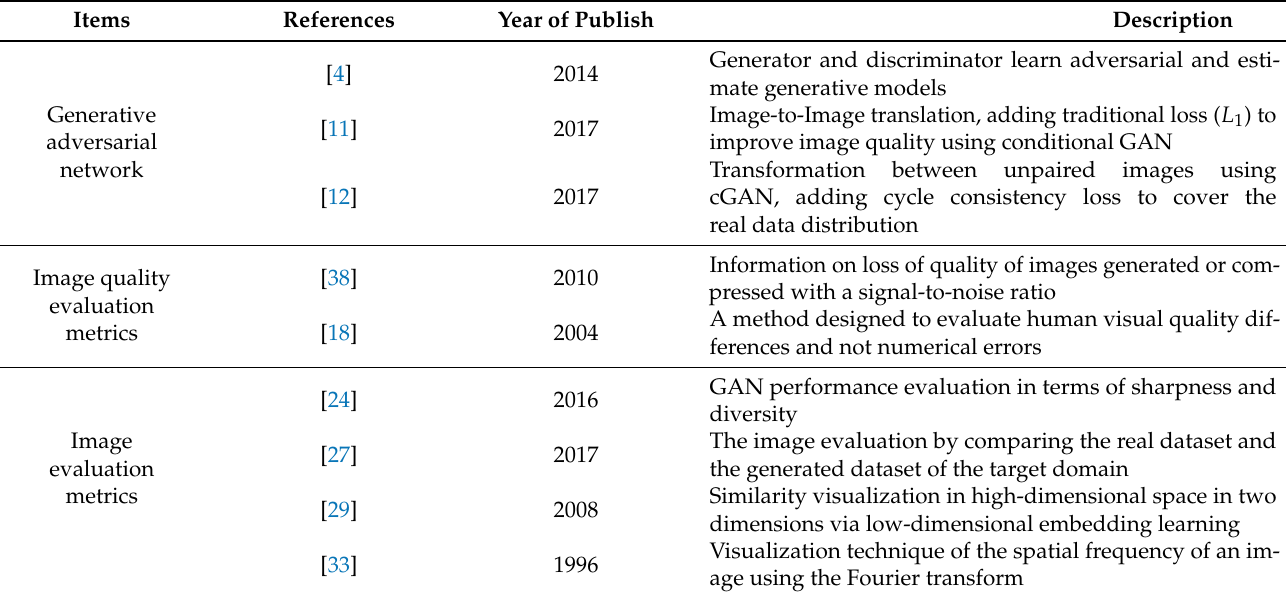
Table 1. The previous literature for image generation and evaluation